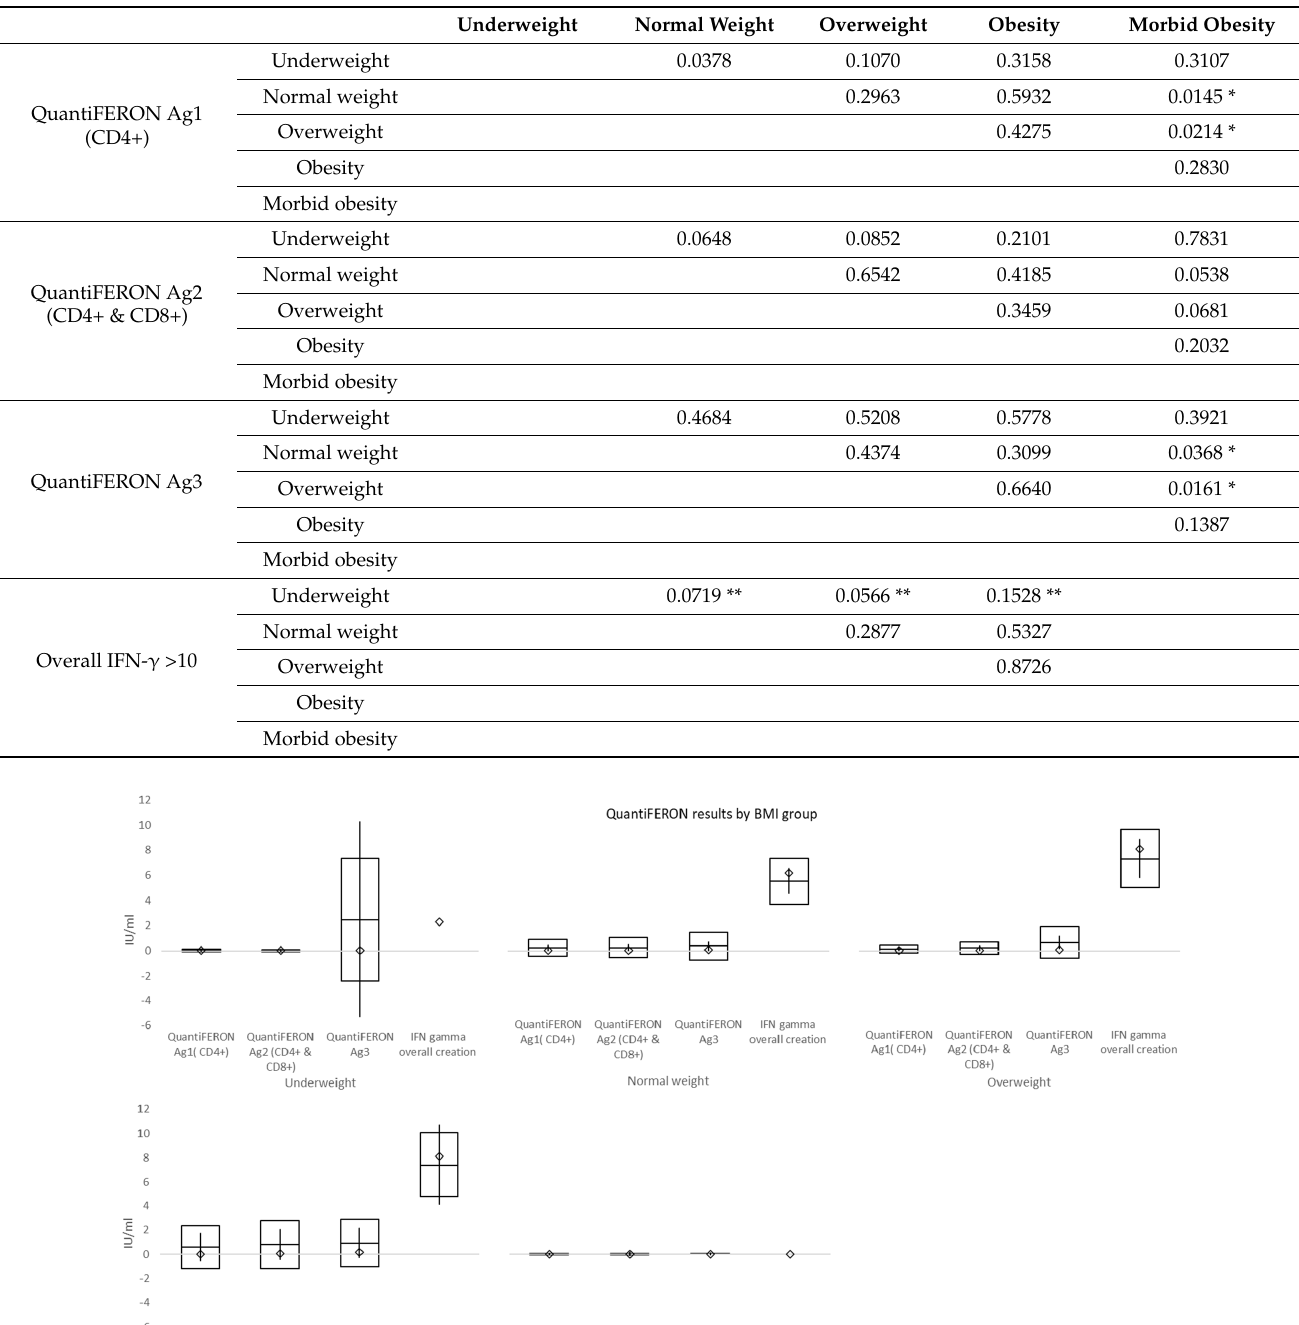
Table 7. Two-sided p -values for difference in laboratory tests between body mass index (BMI) groups. * The significant difference. ** The two-tailed significance probability that could not be measured, therefore p -value for equal variance is assumed.